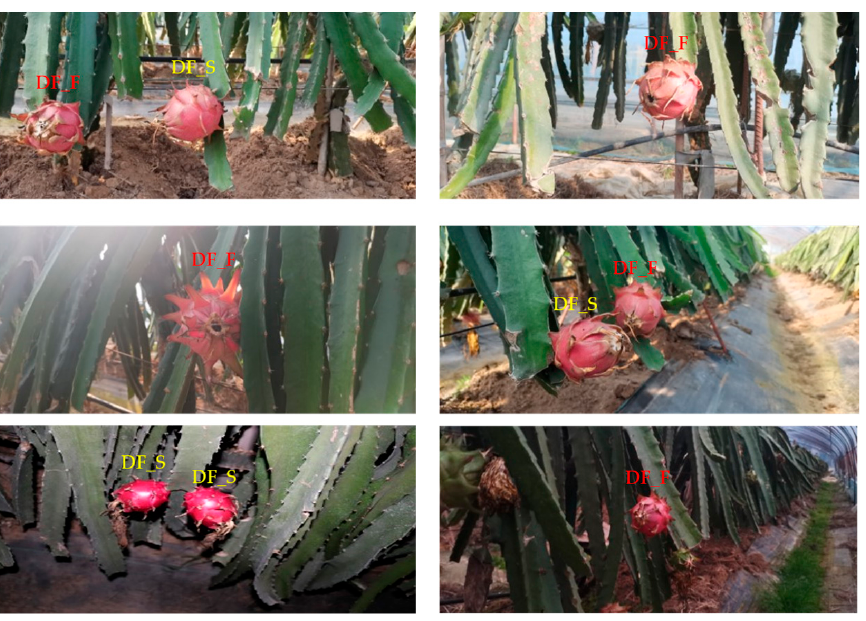
Figure 1. Data of two categories of dragon fruit taken at different times. DF_S denotes dragon fruits in the side, and DF_F denotes dragon fruits in the front.